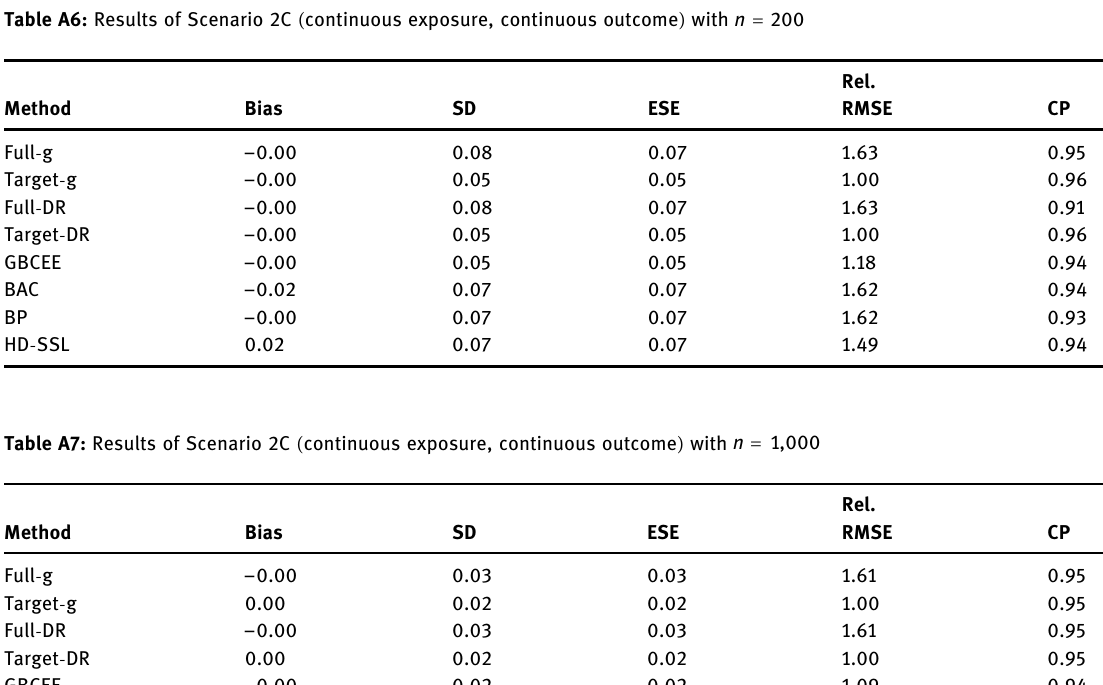
Table A6: Results of Scenario 2C ( continuous exposure, continuous outcome ) with n 200 =